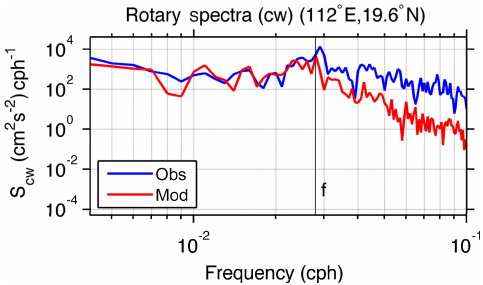
Figure 4. Rotary spectra of clockwise component (upper 10m) at Wenchang (19.6 ◦ N, 112 ◦ E) from model simulations (red) and ob- servations